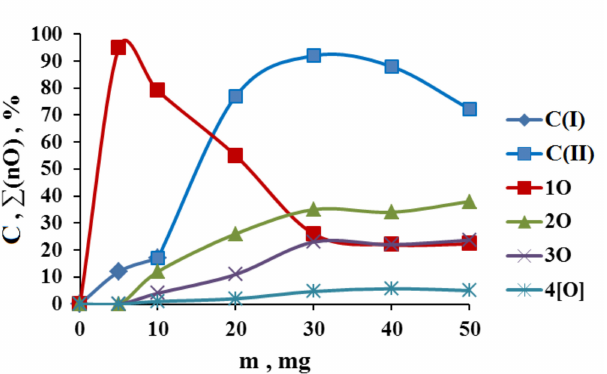
(cid:4) Figure 2. Dependencies of the C (C(I) ( ) and C(II) ( (cid:4) )) conversion and the sum of the products of 0 n -oxygenation, n = 1–4, on the mass m of the catalyst. V(H 2 O 2 ) = 1 mL, T = 50 ◦ C, t = 5 min. The maximum C falls on the interval V(H 2 O 2 ) = 0.5–1.0 mL (Figure 3). In the range V(H 2 O 2 ) = 0.5–2.0 mL, the content of intermediate 2O products remains approximately